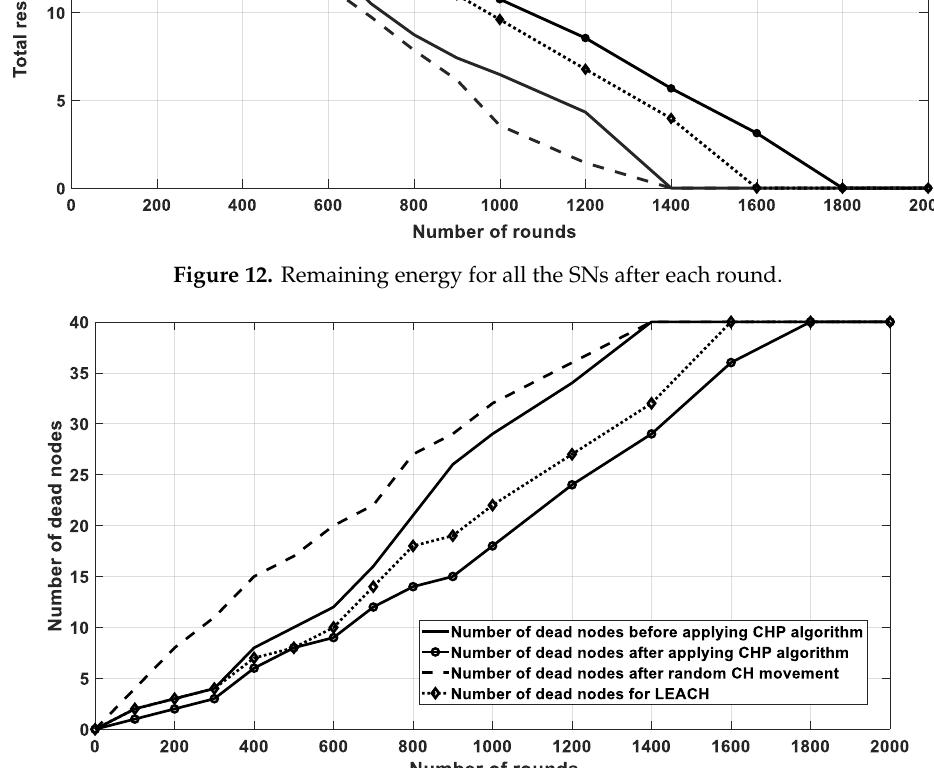
Figure 12. Remaining energy for all the SNs after each round.